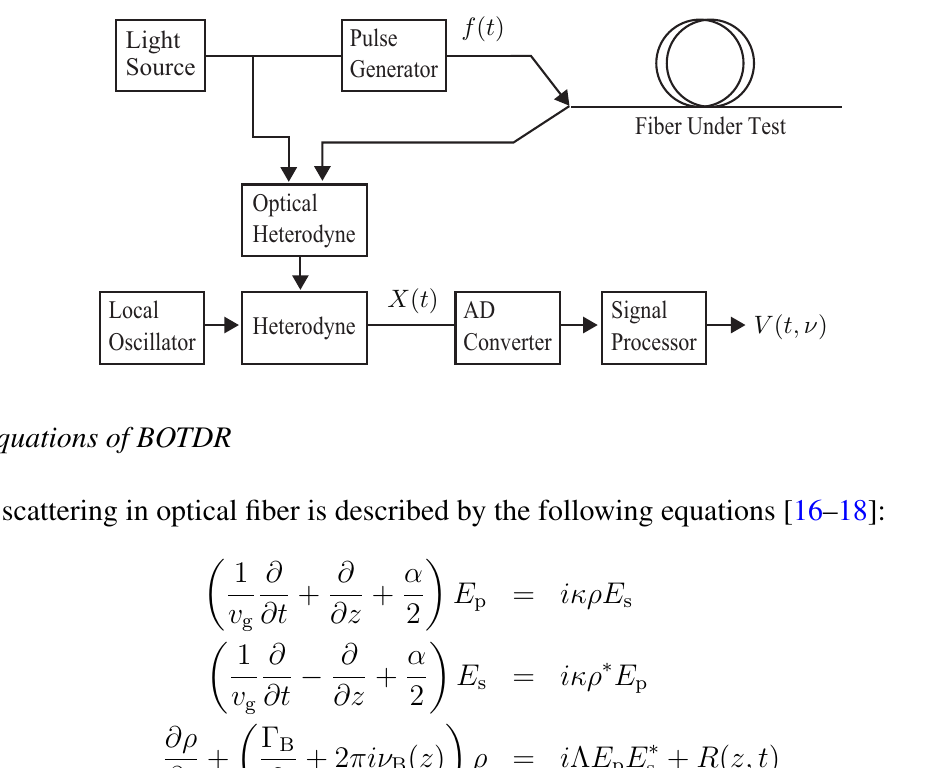
Figure 1. Block diagram of Brillouin optical time-domain reflectometry